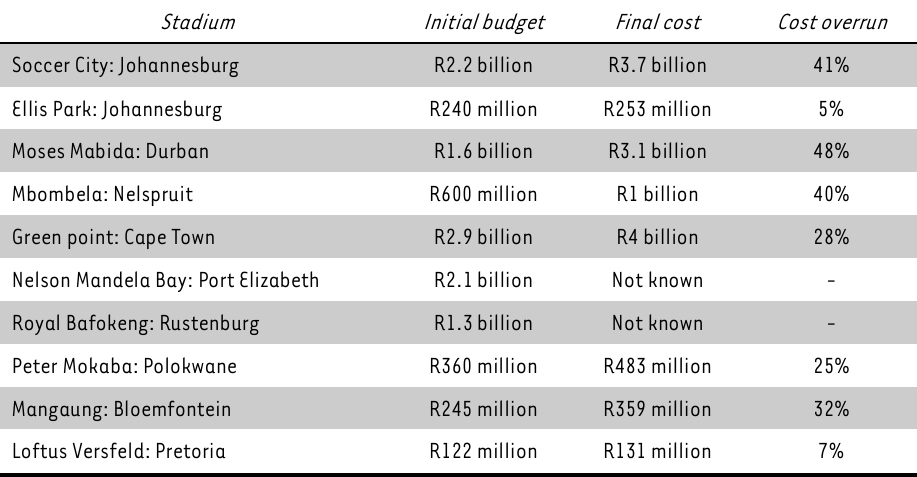
TABLE 5: Budget vs. indicated final costs of world-cup 2010 stadia Stadium Initial budget Final cost Cost overrun R2.2